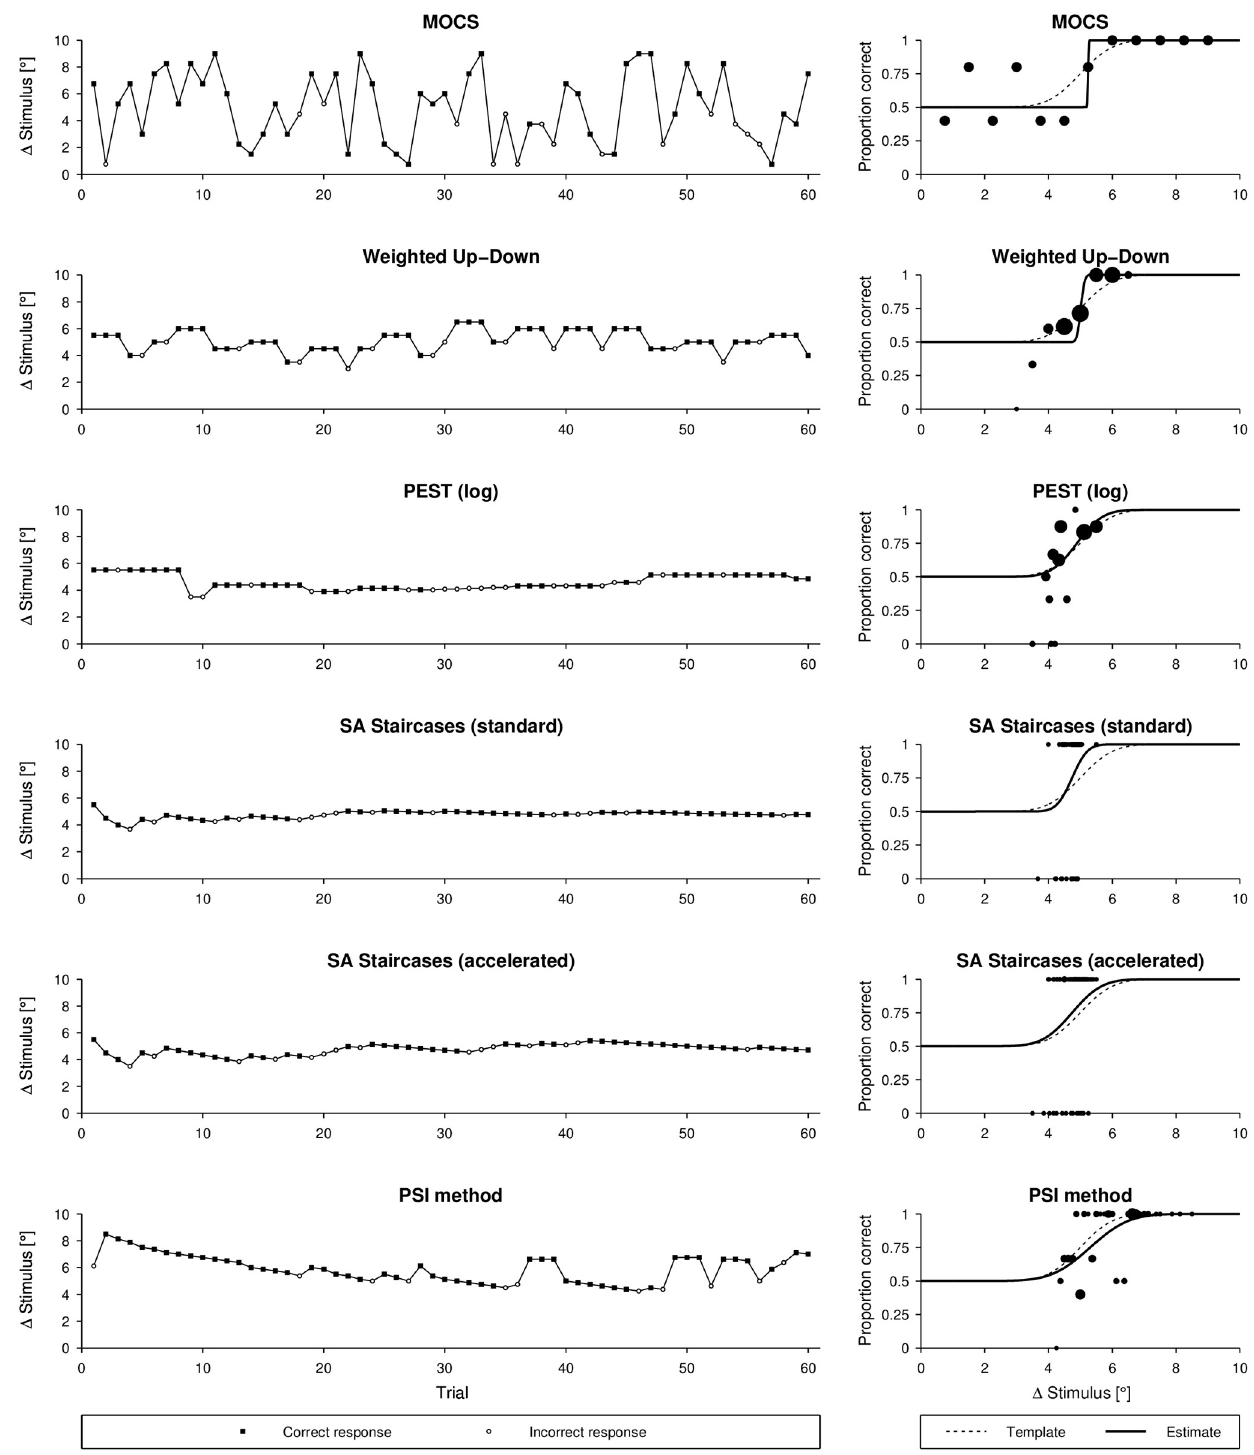
Fig 5. Examples of simulated sequences and psychometric functions for different sampling procedures. Examples for a template c > comparison of the psychometric function of the template with the resulting fit using a Maximum Likelihood criterion. The size of the black dots indicates the number of repetitions at same stimulus level.